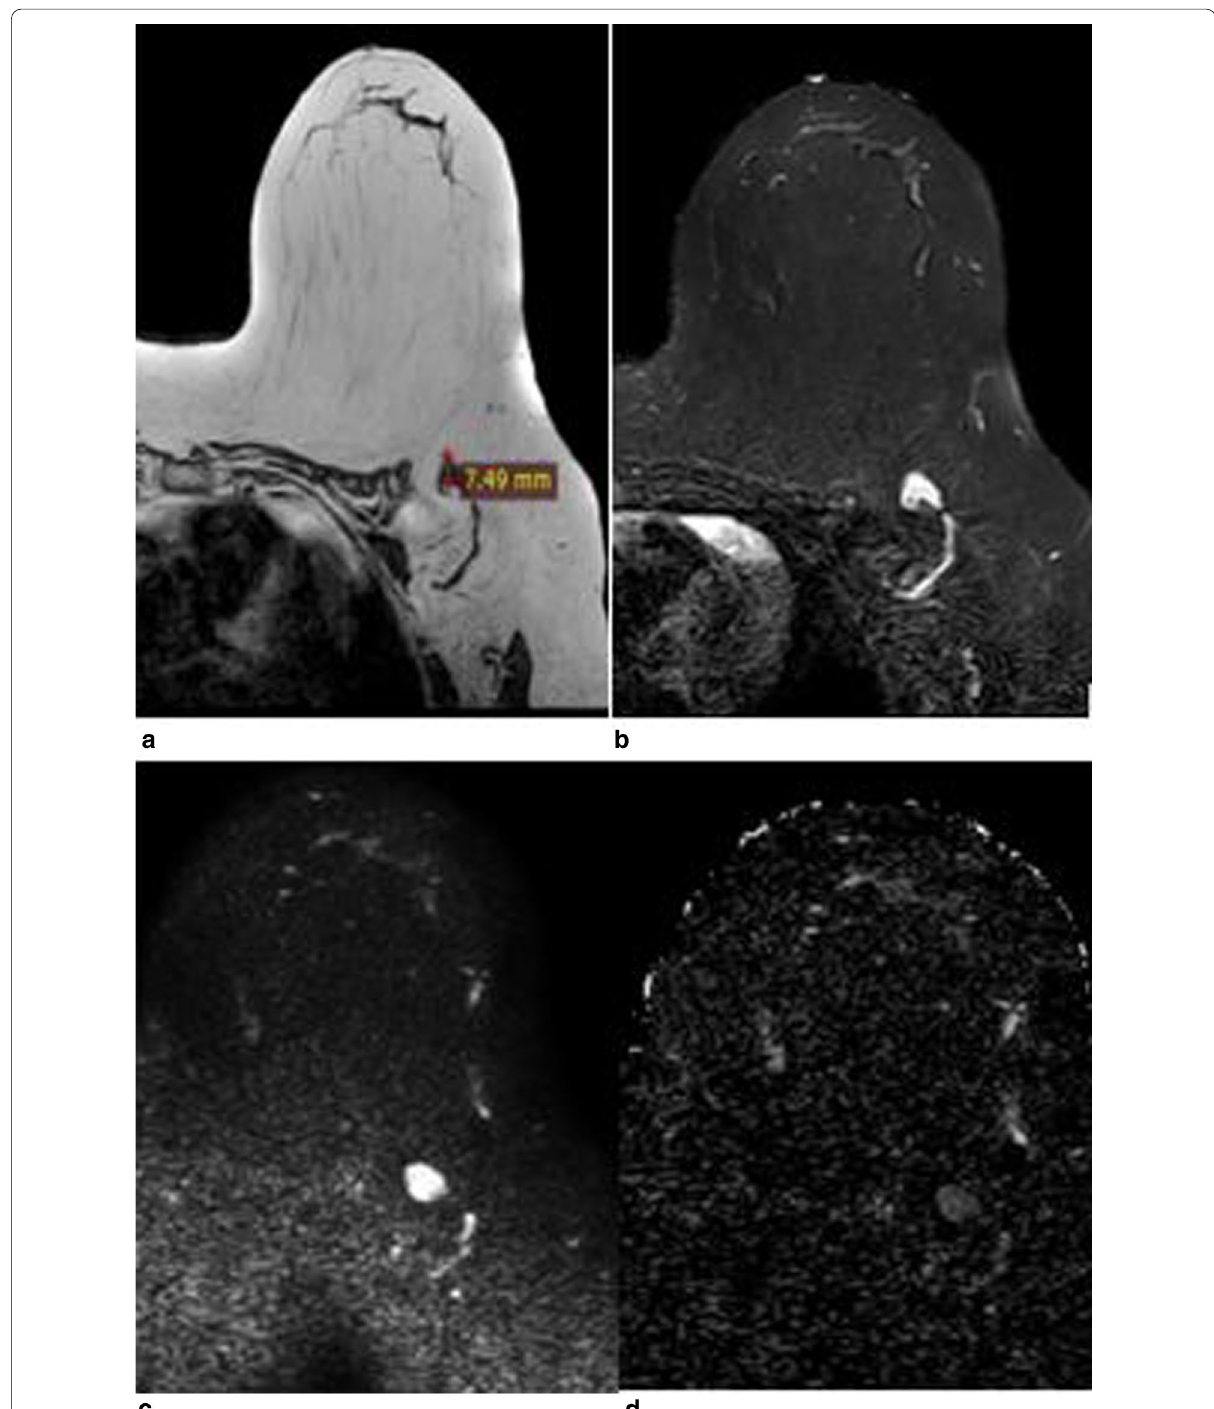
Fig. 7 A 54-year - old female a , b T1W1 and STIR revealed enlarged left axillary lymph node with focal cortical thickness measures (0.74 cm) c , d DW-MRI and ADC map revealed increased SI in DWI and dropped in ADC map with ADC value (0.607 while pathology proved to be benign reactive lymph node (false